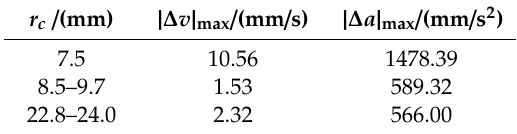
Table 5. The maximum amplitude of velocity and acceleration with di ff erent expanding radius.